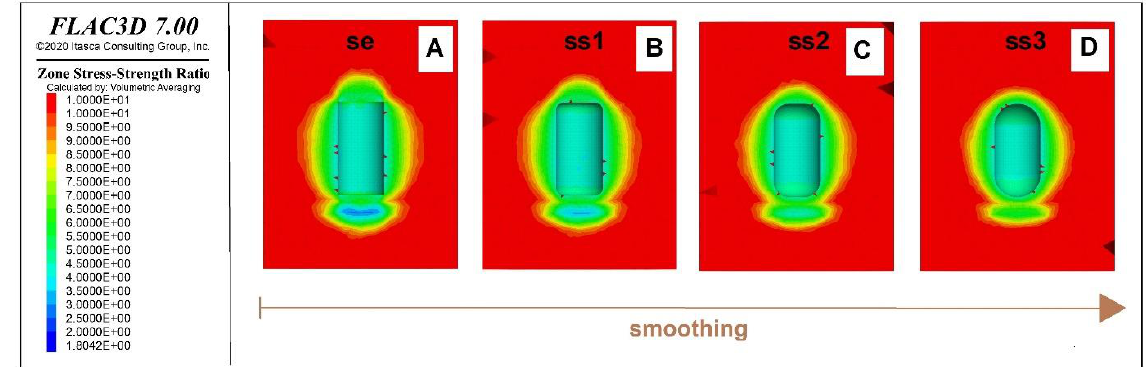
Figure 18. The SSR value and distribution in the cylindrical caverns; the last injection period ( A – D ).